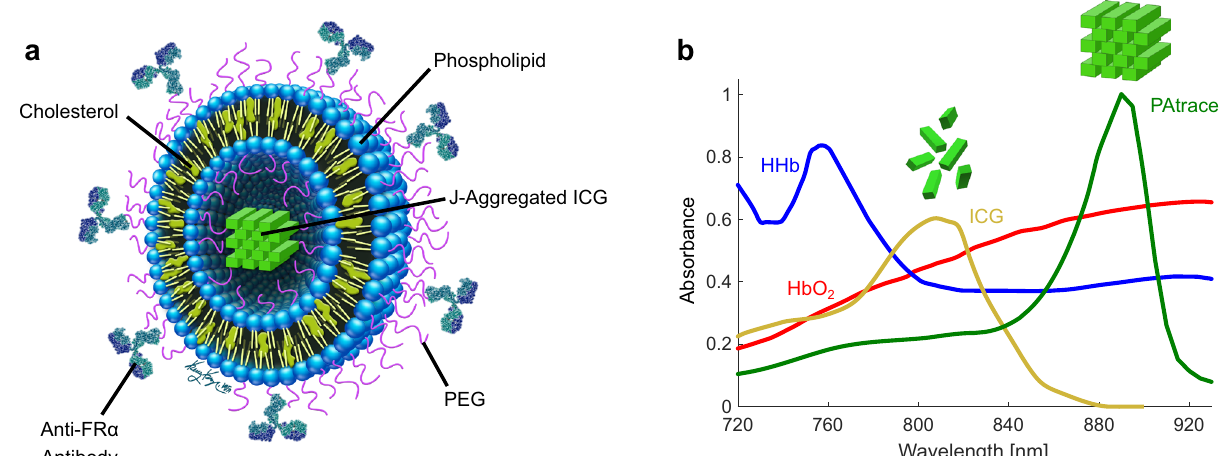
Fig. 1 PAtrace design. a Schematic of FR α -targeted PAtrace nanoparticle (FR α -PAtrace). b Optical absorbance spectra of endogenous HbO 2 (red) and HHb (blue) with exogenous monomeric ICG in blood serum (gold) and PAtrace (green) demonstrate advantages of unmixing PA images for PAtrace in the presence of blood. Notably, PAtrace ’ s sharp ~890 nm peak facilitates greater spectral separation from hemoglobin, while increased peak optical absorption relative to concentration-matched ICG increases PA signal